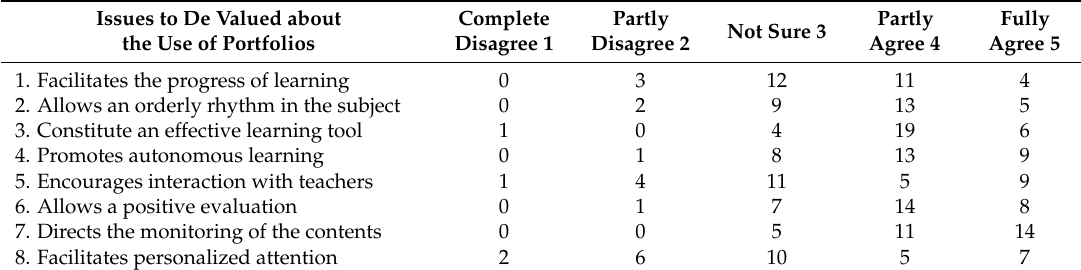
Table 3. Valuation of portfolios by users.